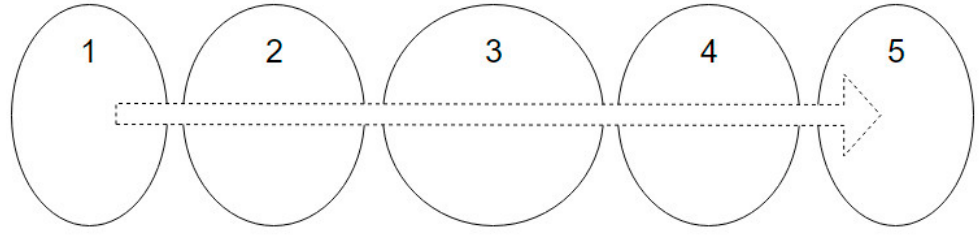
Figure 5. Natural order of activation with a forward direction from left to right.